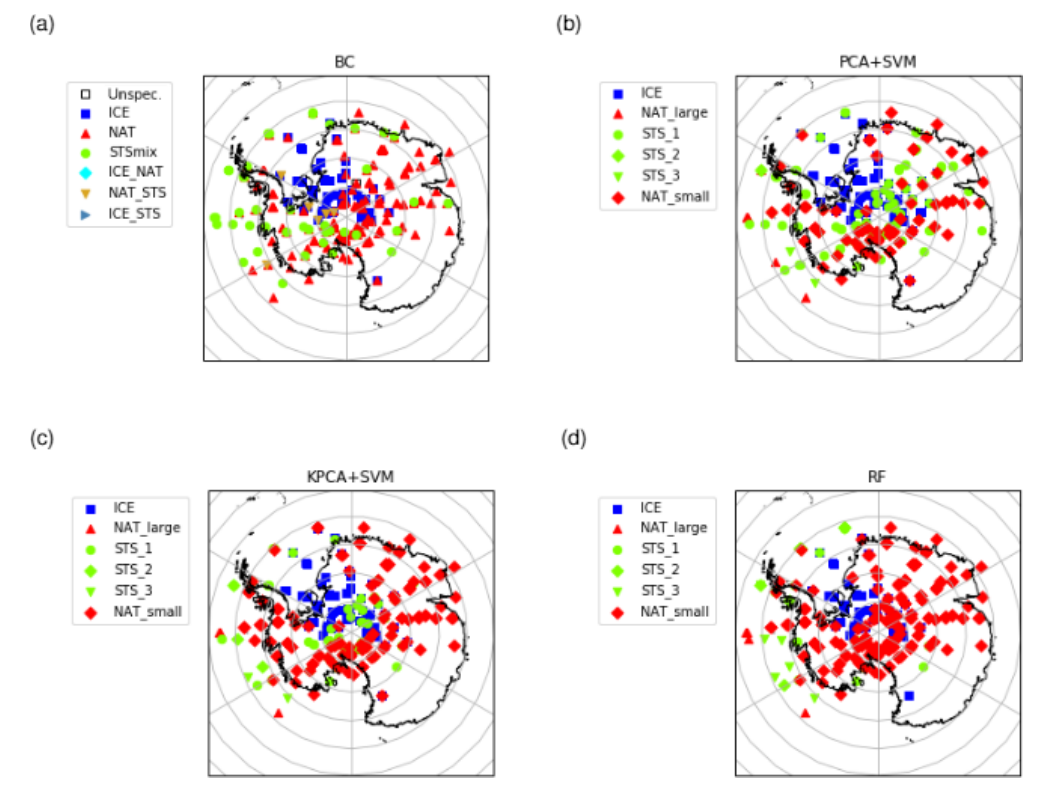
Figure 9. Same as Fig. 8 but for 26 August